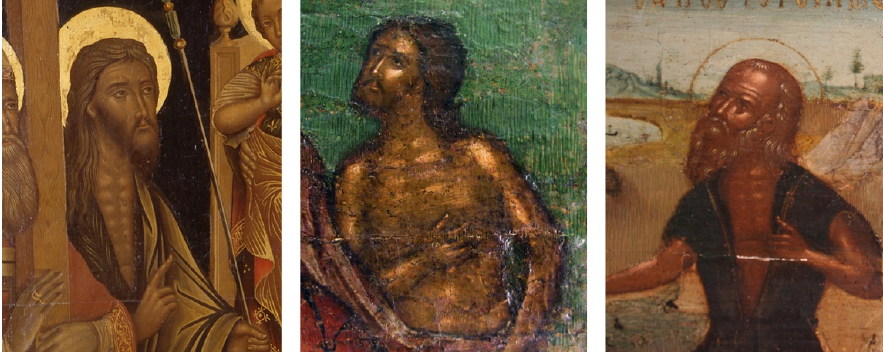
Figure 7. Angelos Bitzamanos. The Scottivoli altarpiece (detail), 1508. Vatican City, Apostolic Palace ( left ) © Musei Vaticani. Reproduced with permission; Angelos Bitzamanos, Saint Martin and Saint Jerome (details from the altarpiece of Komolac), 1518. Dubrovnik, Franjevaˇcki Samostan ( middle and right ). Author’s photos; Figure created by